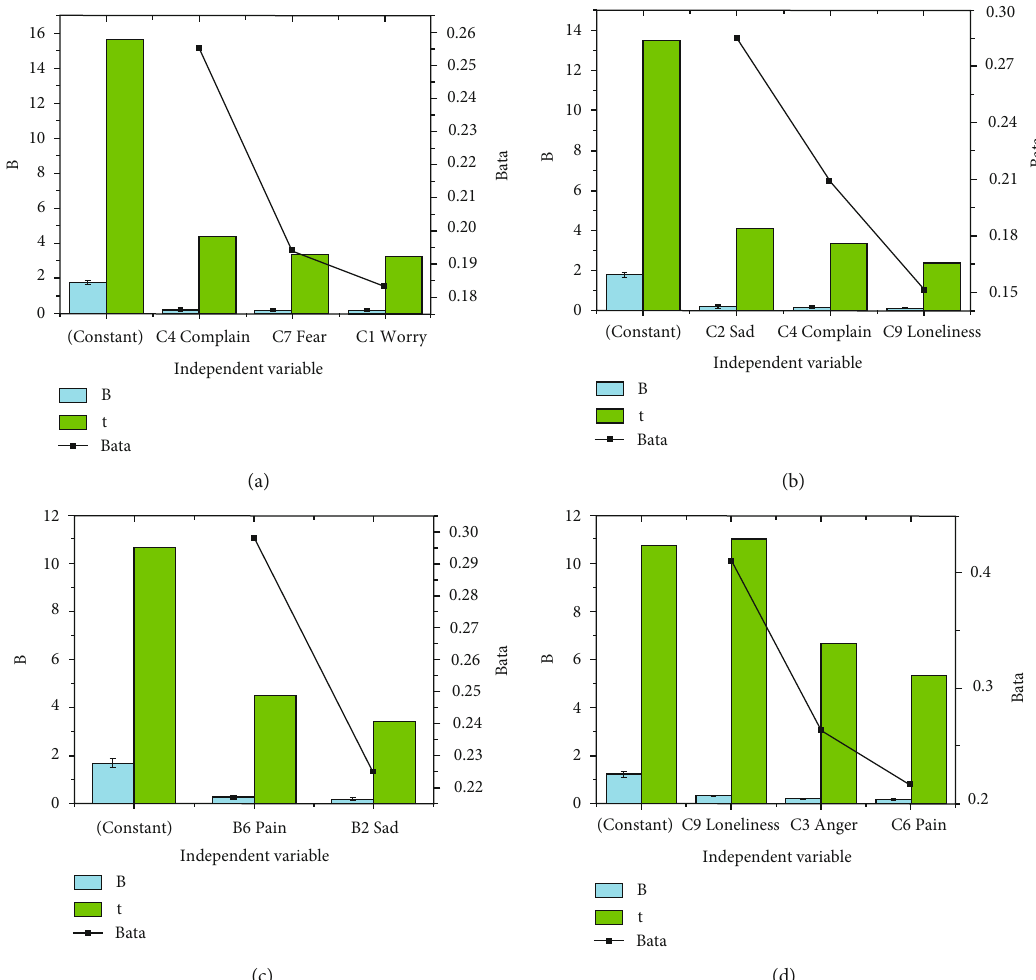
Figure 8: QS results of alleviation e ff ects of di ff erent music styles on negative emotions around the world ((a) “ Vienna Woods Waltz ” ; (b) “ Carmen ” ; (c) “ Remembrance ” ; (d) “ Balance ” ; B represents nonstandardized coe ffi cient; t is the emotional